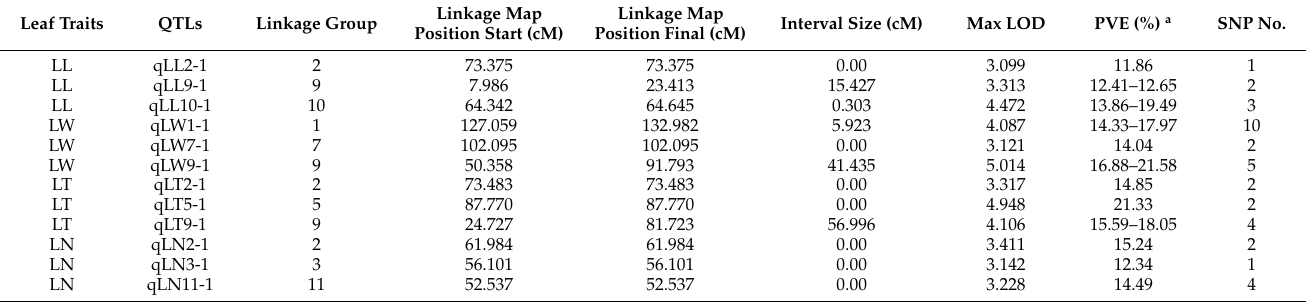
Table 6. Statistics of QTLs for four leaf-related traits detected in the F1 population of Paphiopedilum orchids. Leaf